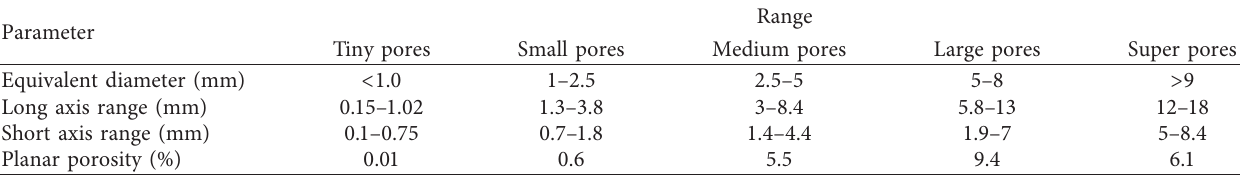
Table 6: Statistical results of pores feature for specimen 2#.